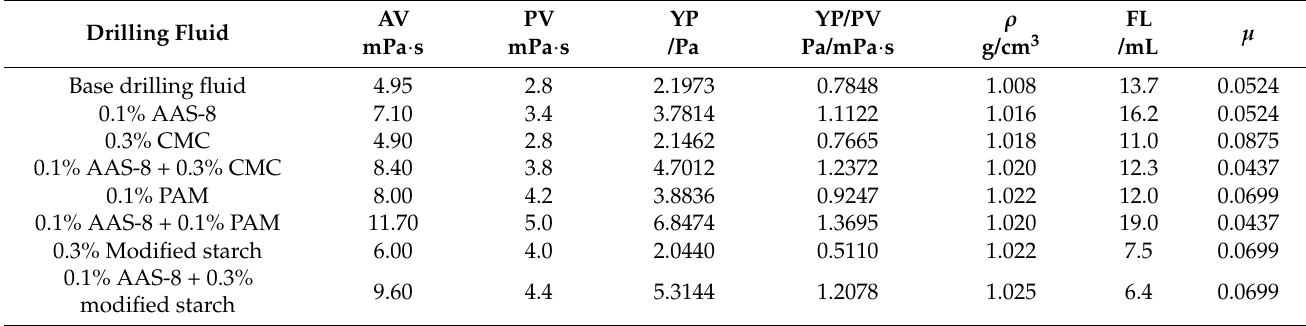
Table 2. Results of the analysis of the drilling fluid rheological properties.